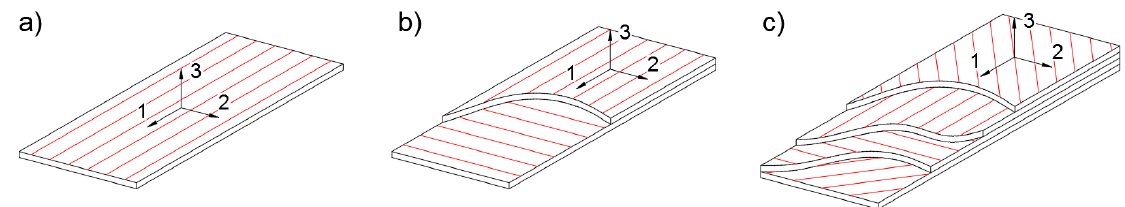
Figure 9. Designations and orientations of the coordinate system for layers: unidirectional reinforced ( a ), bidirectional reinforced ( b ) and face laminate ( c ).